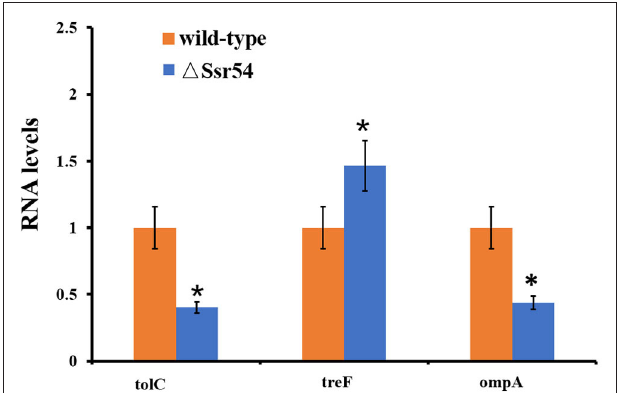
FIGURE 8 | qRT-PCR for three mRNA targets of Ssr54 . Level of three mRNA targets in the 1 Ssr54 mutant strain under hyperosmotic conditions expressed relative to the level in wild-type. Statistical analyses were performed using Student’s t -test. Data are representative of three independent experiments. Error bars indicate one standard deviation. *Denotes a significant difference with P <